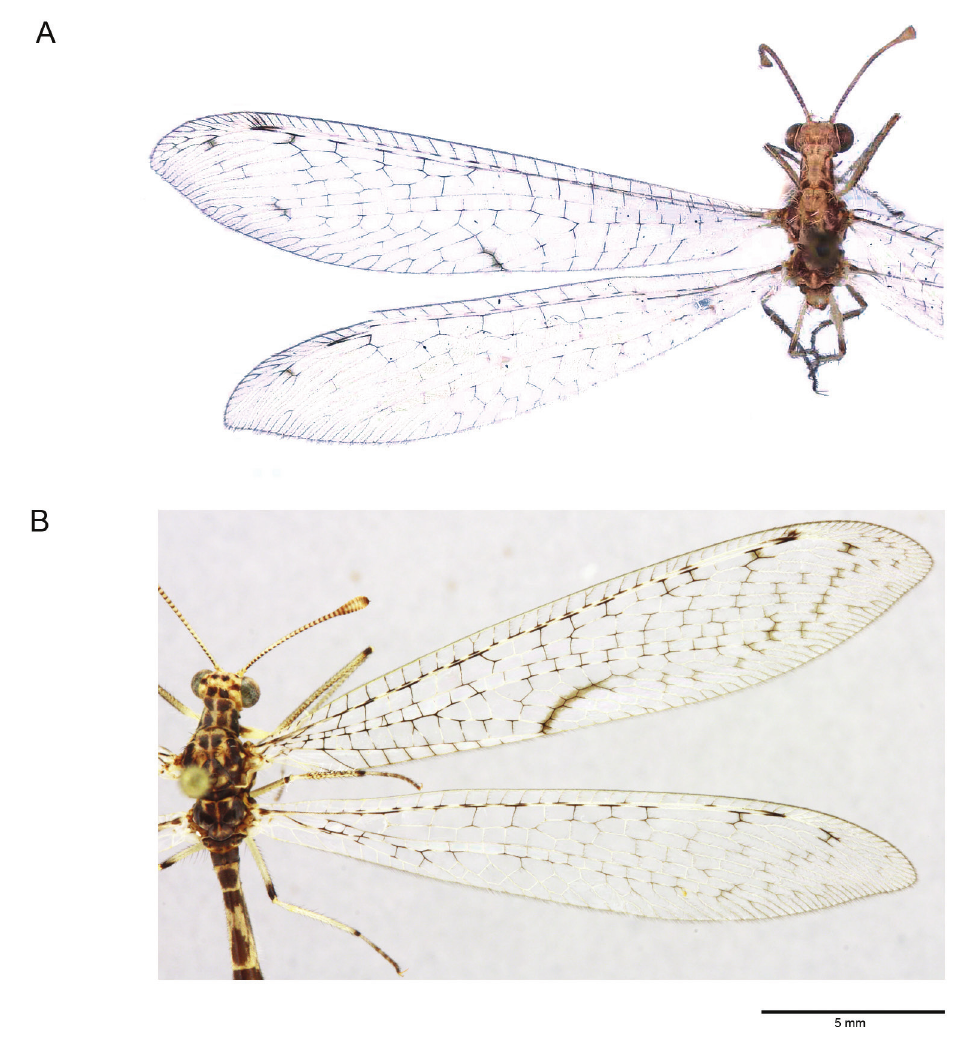
Figure 6. Gymnocnemia spp., holotypes, dorsal view. A Gymnocnemia mirabilis [Sinai, Shreg]; B Gymnocnemia editaerevayae [Morocco, High Atlas, Oukaimeden] (Photo: B. Michel,